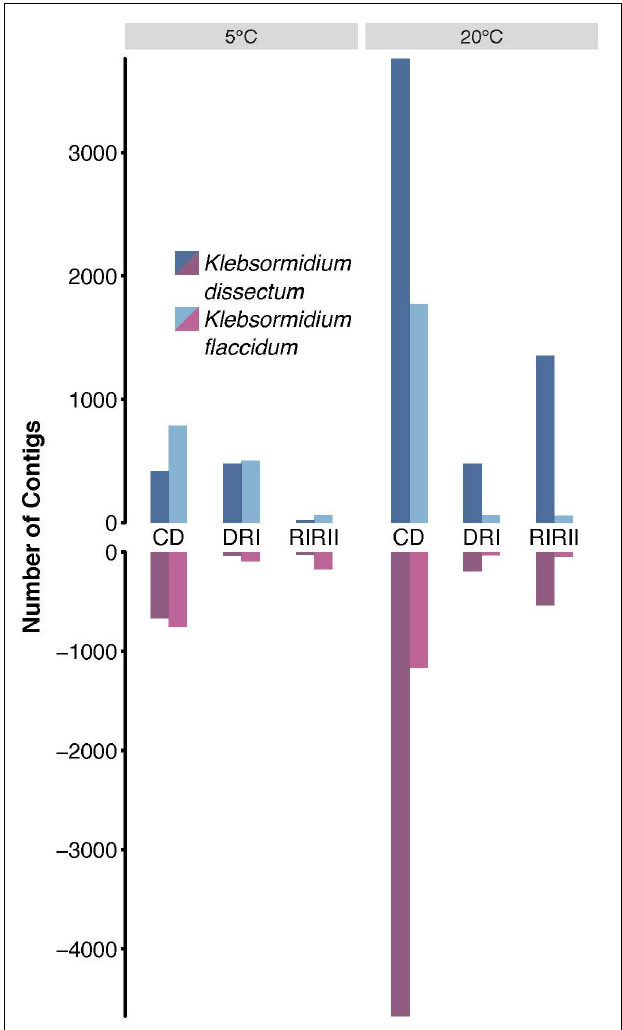
FIGURE 6 | Differential gene expression analysis. The total of upregulated (dark and light blue) and downregulated (dark and light red) contigs of K. dissectum and K. flaccidum upon desiccation and during recovery at 5 and 20 ◦ C. Only contigs with a FDR of less or equal to ≤ 0.001 and a fold change of at least > 4 were